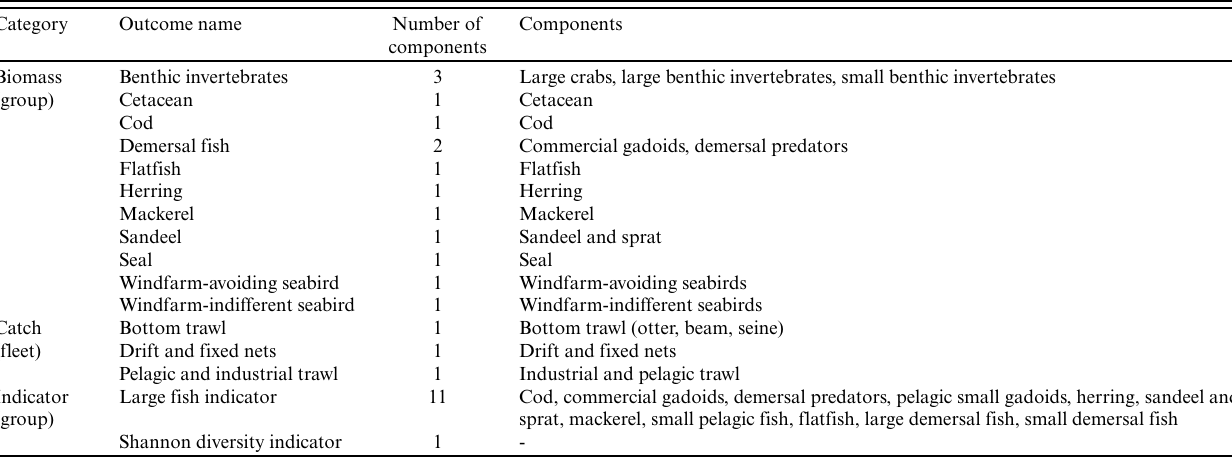
Table 5. Outcomes delivered by Ecopath with Ecosim the marine spatial planning challenge game for the North Sea Ecospace model, covering 11 biomass summaries, three catch summaries, and two ecological indicators. The outcomes labelled as benthic invertebrates and demersal fish contain aggregations of functional groups. The large fish indicator (Engelhard et al. 2015) is a per-cell result of the sum of biomass of cod and commercial gadoids divided by the sum of biomass of all fish. Ecospace in Ecopath with Ecosim release 6.5 and newer versions calculate the Shannon diversity indicator following Shannon (1948).